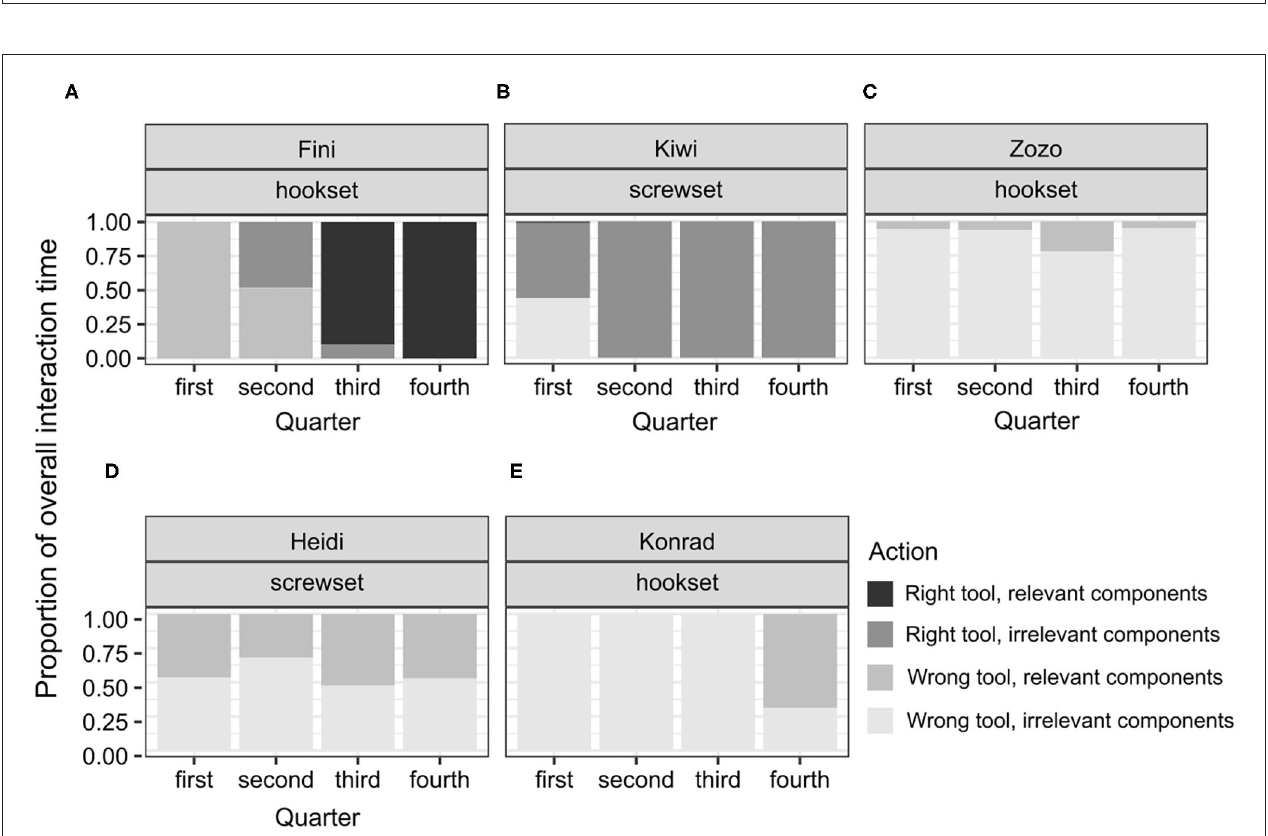
FIGURE 4 | A plot of the proportions of individual interaction times to the overall interaction time throughout the test in the control condition (A–E) . Note that no subjects solved the test in this condition. This display is based on the observed proportions.